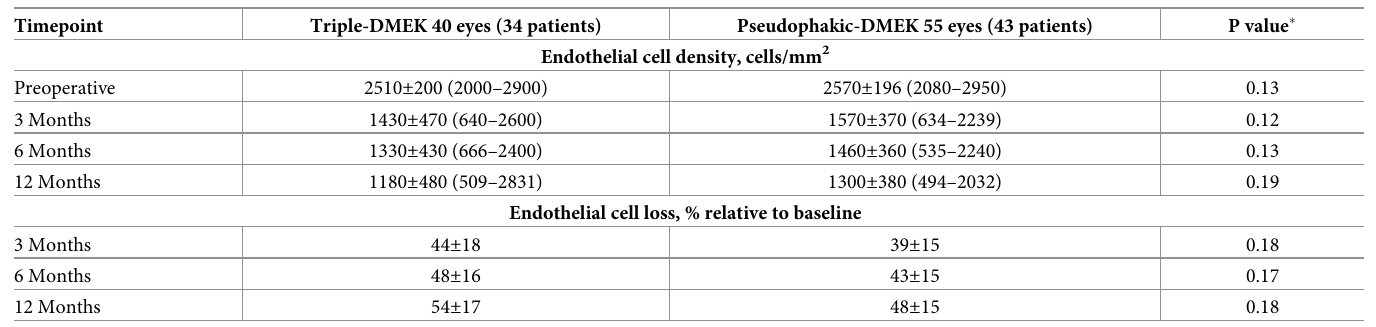
Table 2. Endothelial cell density and loss outcomes of the study groups.